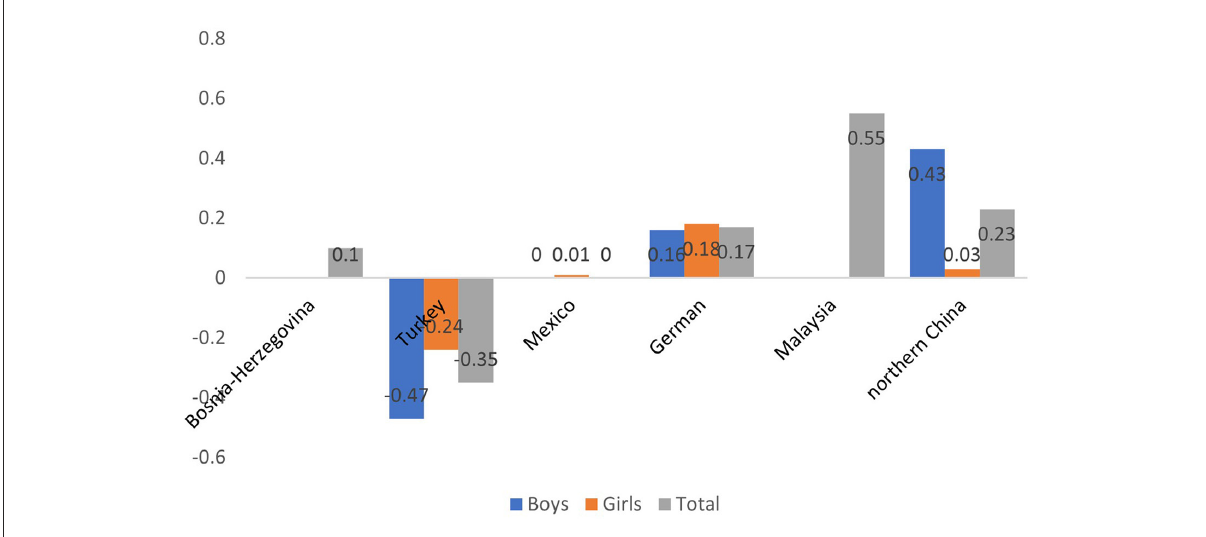
FIGURE5 Application of Cameriere European formula in various